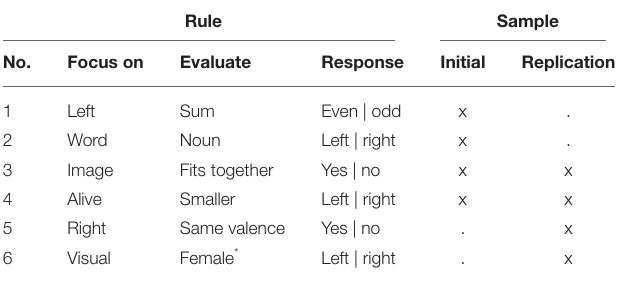
TABLE 2 | Rules of the C3T in the initial and the replication sample ( * grammatical gender). Rule